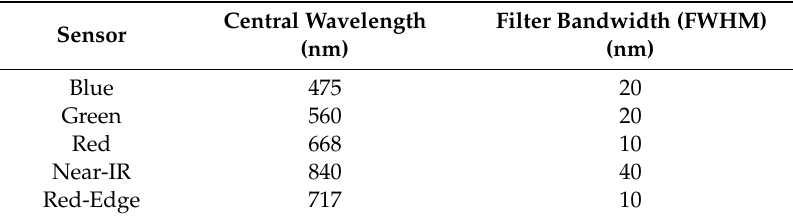
Table 1. Spectral characteristics of the MicaSense RedEdge-M multispectral camera sensors (FWHM = full width at half maximum).